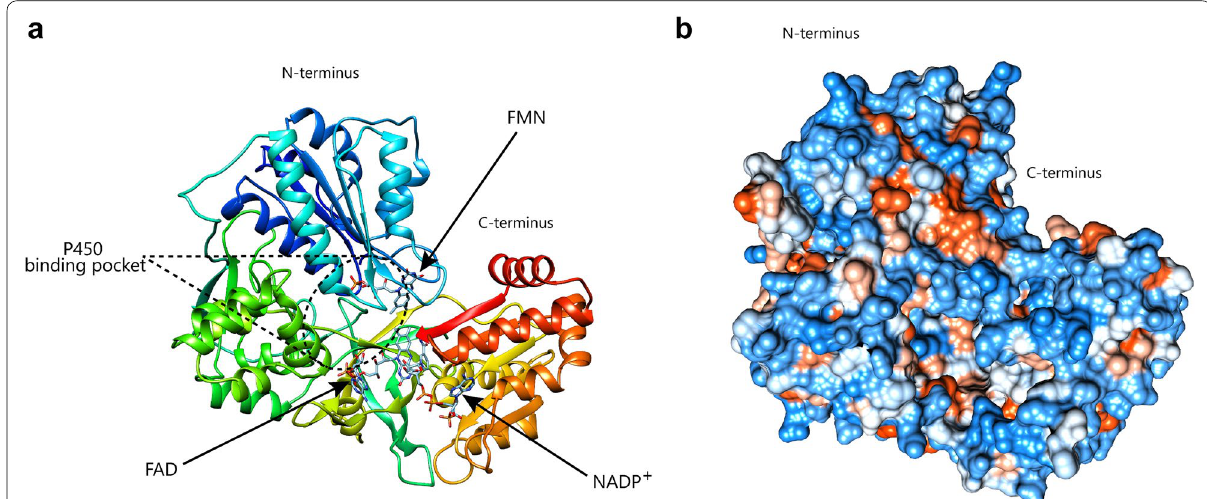
Fig. 5 3-D model and conserved residue prediction for SdCPR. a Consensus matching of SdCPR as ribbon-structures. Ribbon display of the 3-D structures of SdCPR as predicted by PHYRE2 web server using crystal structure Rattus norvegicus (PDB ID: 1J9Z) as template. b Conserved residue analysis of